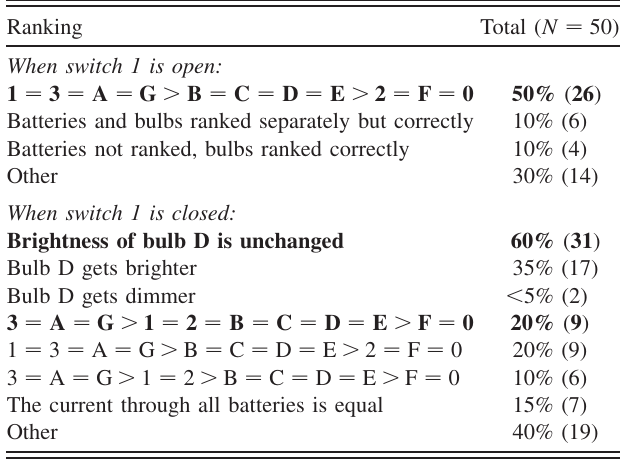
TABLE III. Bulb rankings in multiple batteries in single loops post-test of Fig. 4.